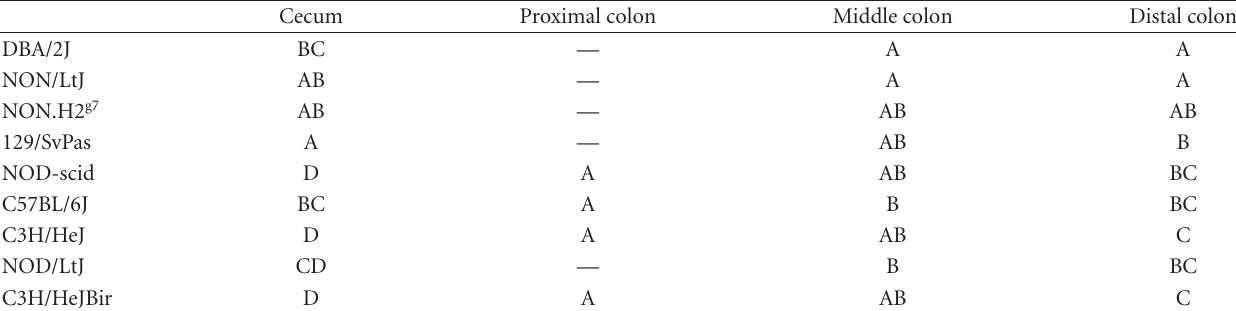
Table 1: Susceptibility to DSS-induced colitis among inbred strains (adapted from [15]). Cecum Proximal colon Middle colon Distal